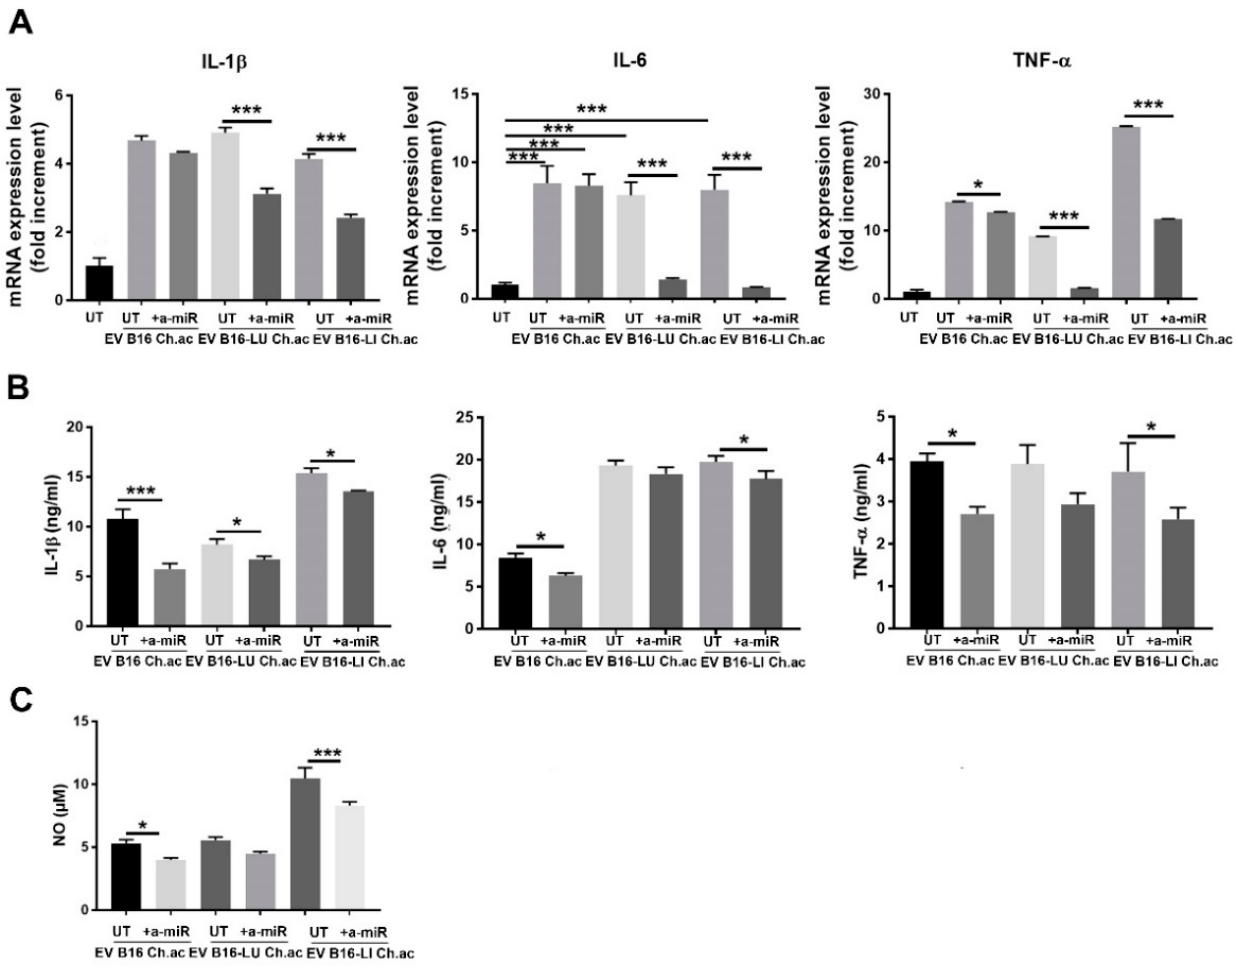
Figure 3. Anti-miR-214 treatment reverted the inflammatory phenotype induced in RAW 264.7 by melanoma-derived acid EV. ( A ) Real-time qPCR of IL-1 β , IL-6, and TNF- α mRNA expression in RAW.264.7 treated with acid-EV derived from B16, B16-LU, or B16-LI cells in the presence or absence of anti-miR-214-3p/5p (a-miR). ( B ) ELISA for IL-1 β , IL-6, and TNF- α production by RAW 264.7 treated with acid-EV in the presence or absence of anti-miR-214-3p/5p. ( A , B ) All conditions were found different ( p < 0.005; one-way ANOVA) from the untreated (UT). ( C ) NO production by